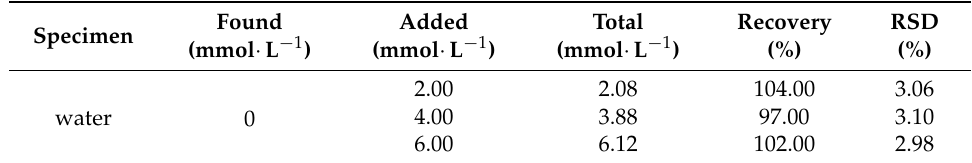
Table 1. Detection results of TCA in the lab water specimen (n =